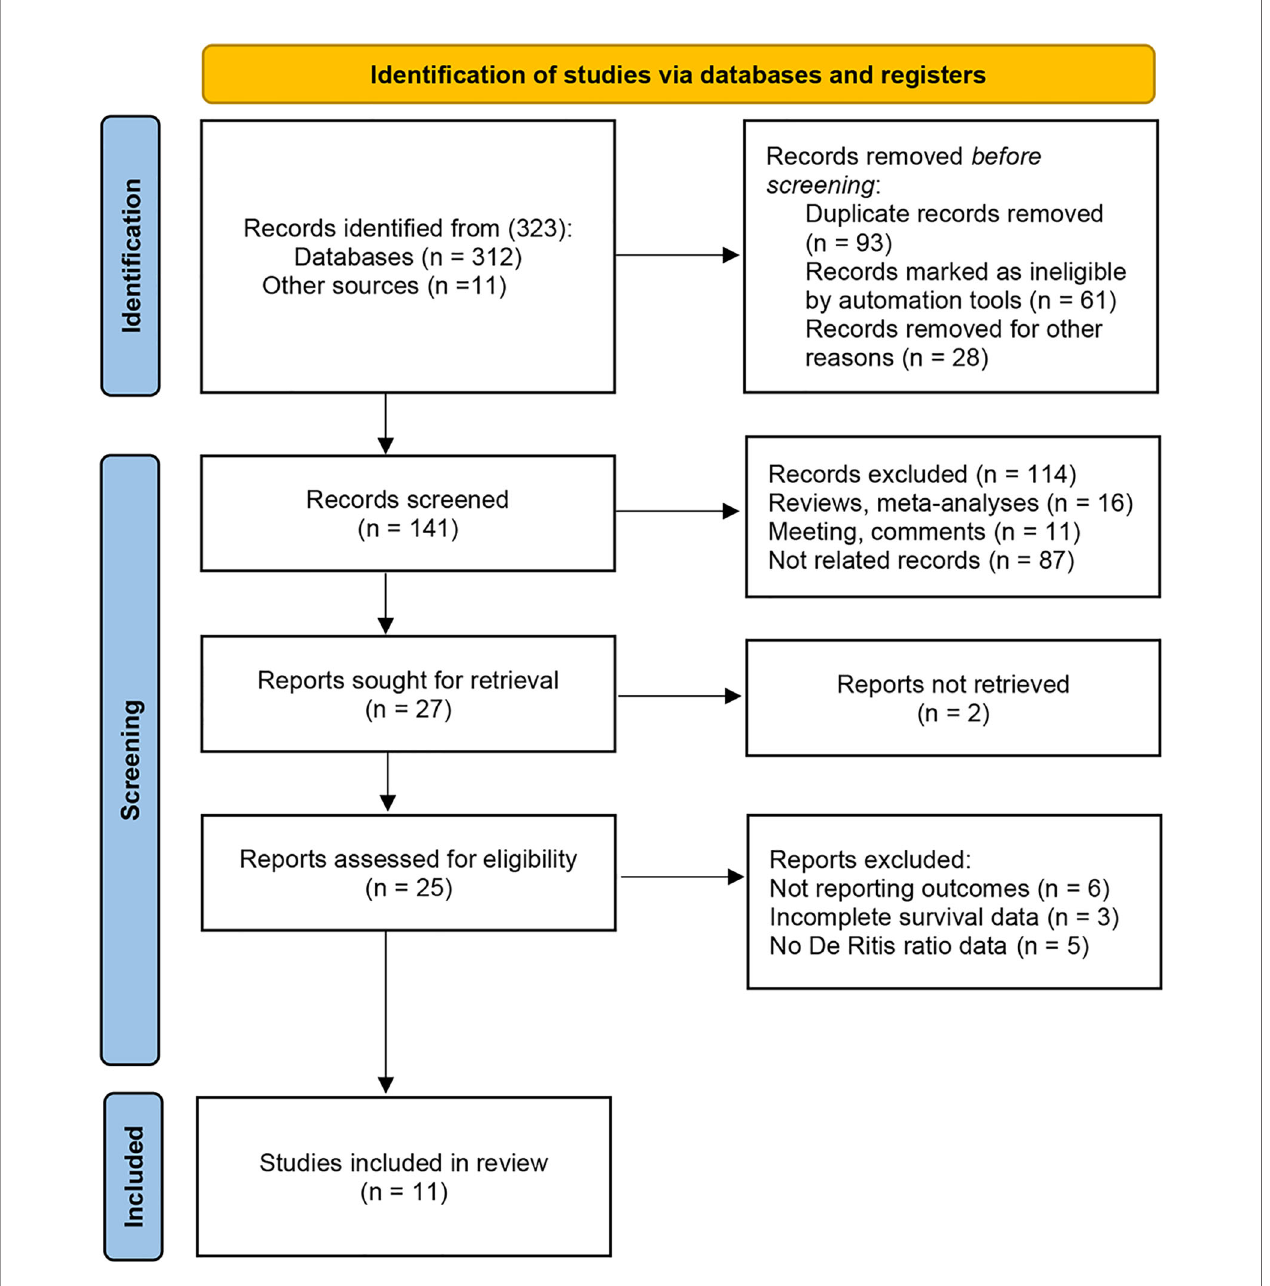
FIGURE 1 | Flow diagram of studies identi fi ed, excluded, and